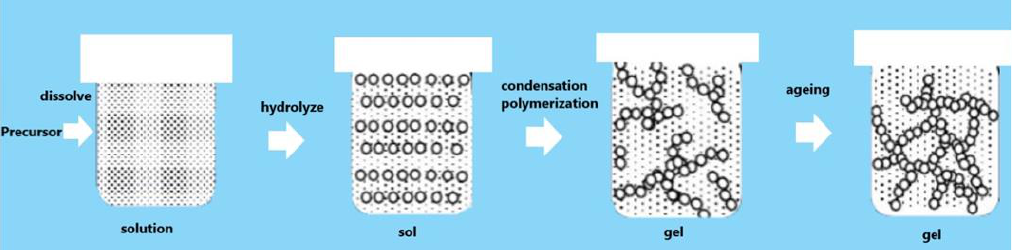
Figure 11. Flow chart of sol-gel method.